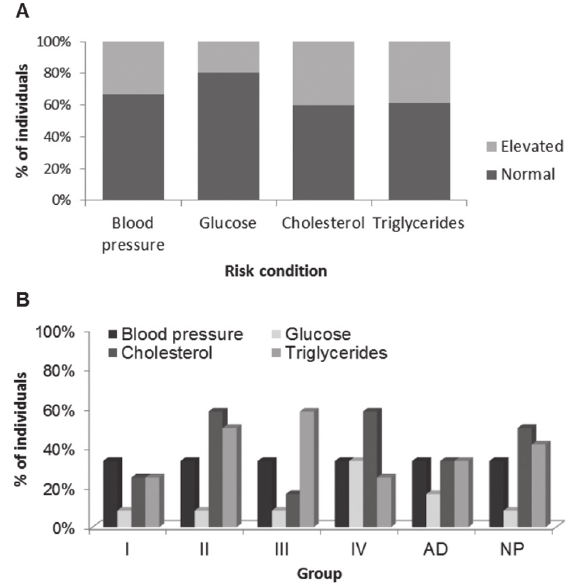
Figure 1 - Prevalence of the risk conditions of our interest. (A) Percentage of individuals with normal and elevated values of blood pressure, glucose, total cholesterol and triglycerides in our total population (N=72). (B) Percentage of individuals within each experimental group (n=12) presenting elevated levels for our risk conditions of